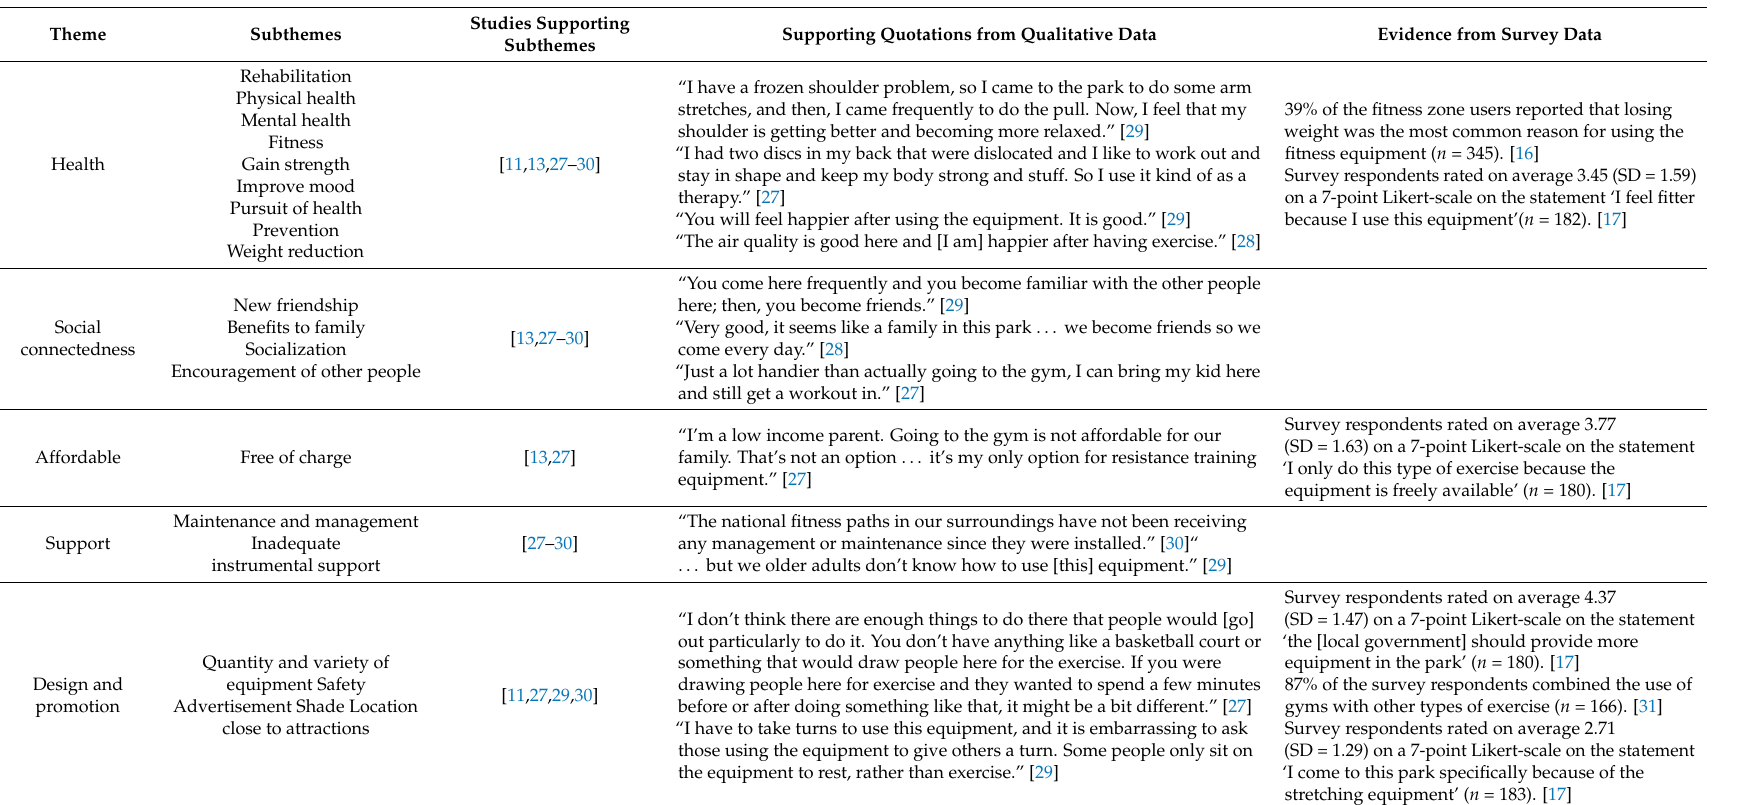
Table 3. Recurring themes, subthemes related to experiences, and perceptions of public exercise